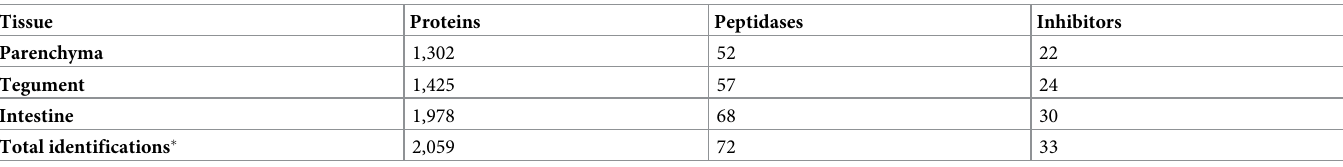
Table 1. Resulting numbers of identified proteins in each